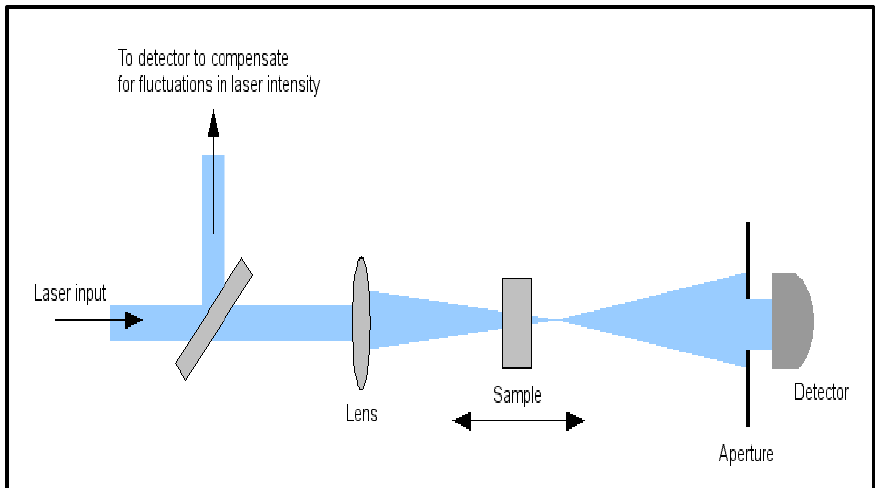
Fig.1: Device of the Z-scan approach [14].